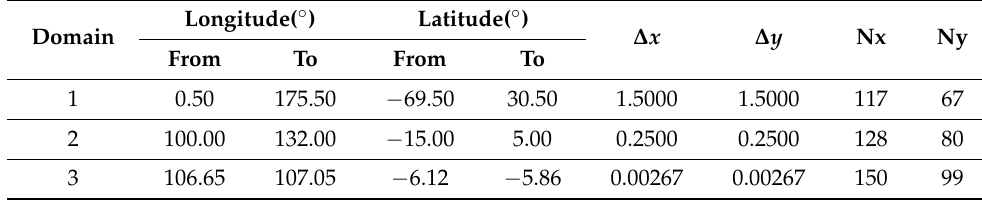
Table 1. Numerical configuration for nested wave